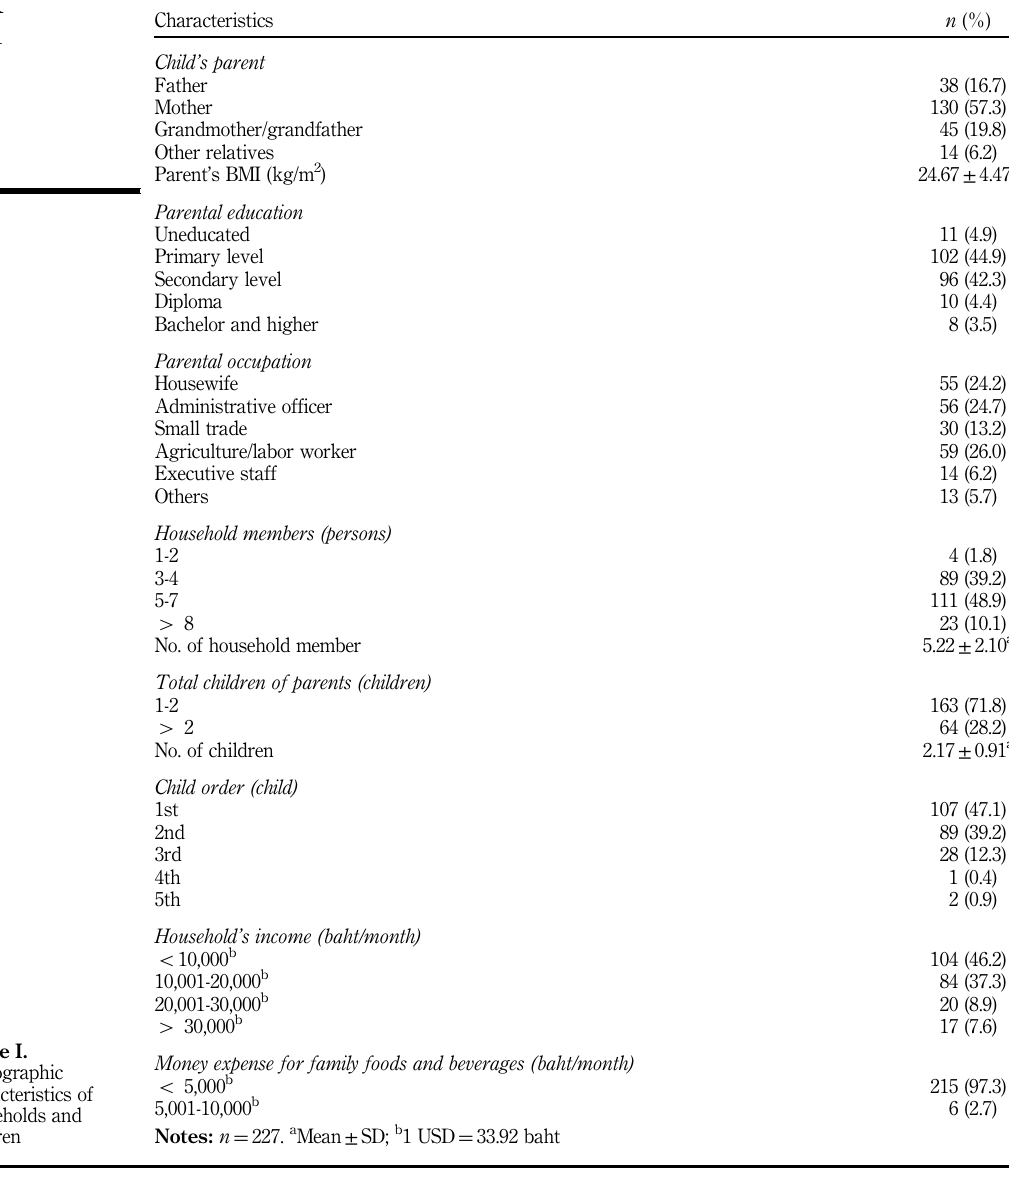
The nutritional status and eating behaviors of children is presented in Table II. Mean BMI- for-age Z -score of boys was significantly higher than that of girls and BMI values of both genders were within the normal range. The height and total body fat of girls were significantly higher than that of boys ( p ¼ 0.027 for height and p ¼ 0.028 for body fat), whereas mean WC value of girls was smaller than that of boys ( p ¼ 0.023). Regarding to